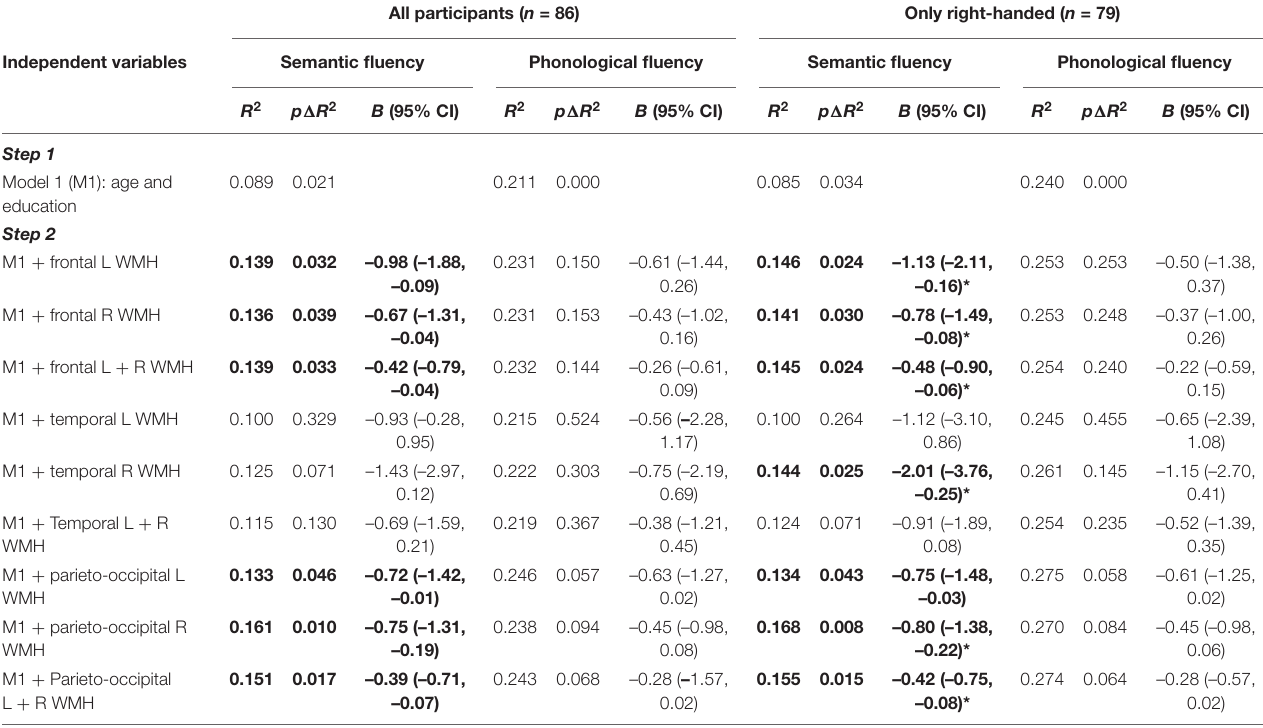
TABLE 3 | Regression models predicting word fluency performance from white matter hyperintensities. All participants ( n = 86) Only right-handed ( n = 79)